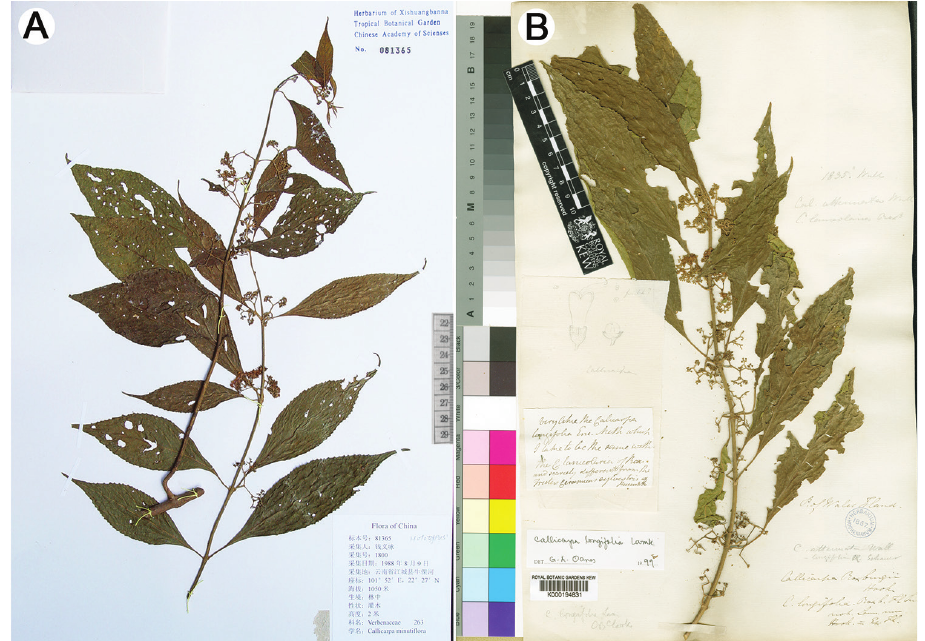
Figure 1. Type of Callicarpa minutiflora Y. Y. Qian and C. longifolia Lamarck. Taxonomic